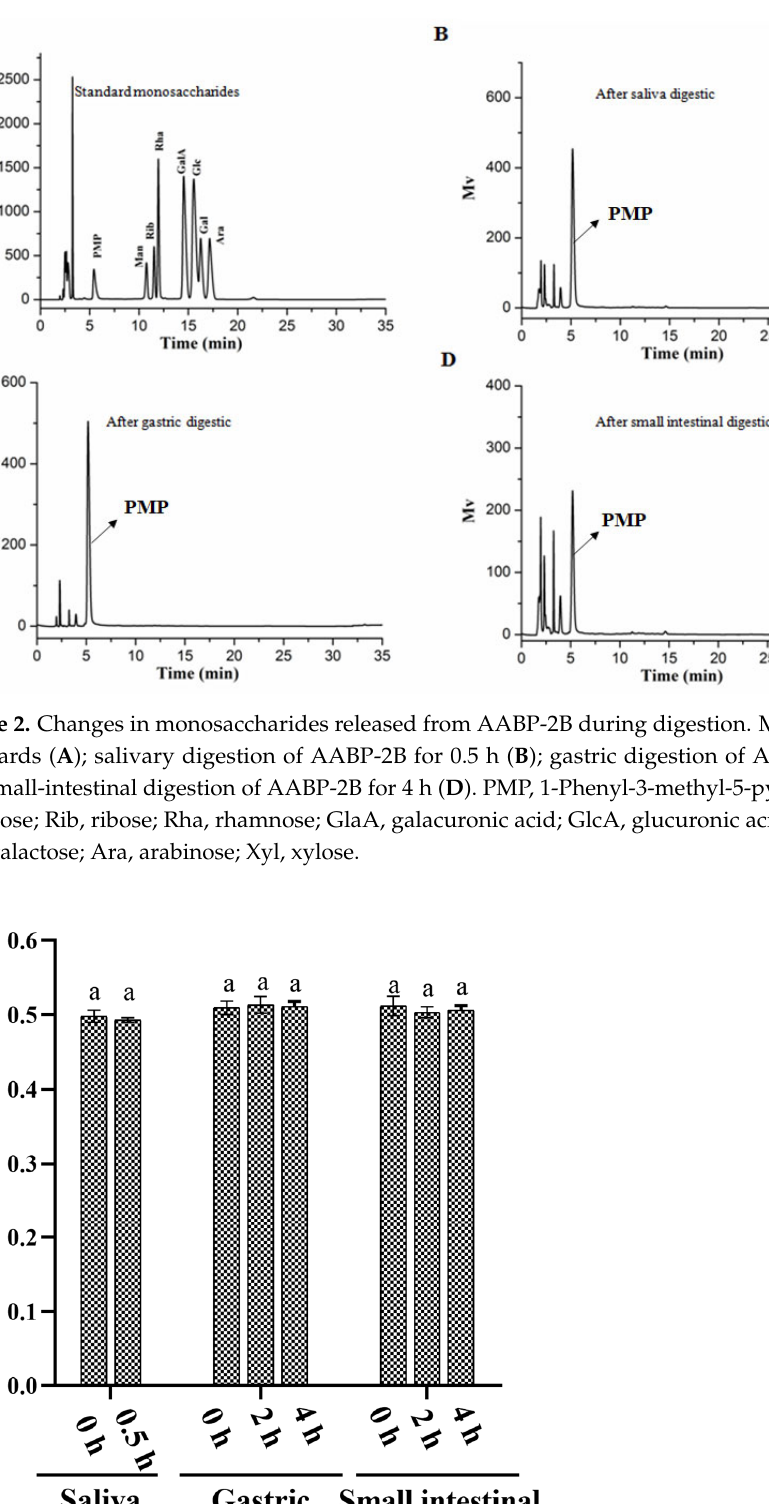
Figure 1. HPGPC chromatograms of polysaccharides. The changes in the molecular weight of